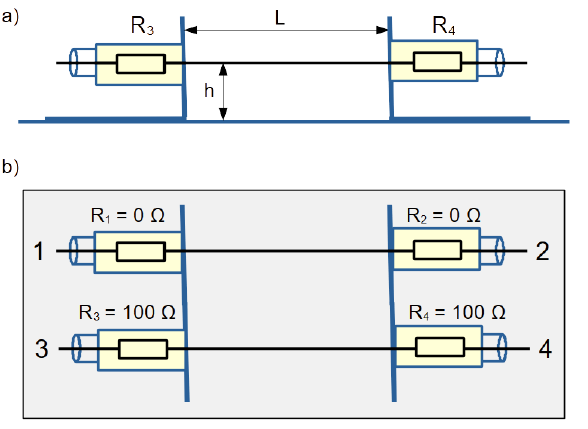
Figure 4. A simple four-port composed of two paths: side view ( a ) and bird’s eye view ( b ). The four-port was built with two single paths. Each path possessed two adapters, each composed of an N-connector to a laboratory cable 4 mm socket, mounted in the L-shape aluminum profile, which were placed face to face at the height of h = 3 cm above the reference plate and connected with a copper cylindrical rod with a diameter of φ = 2 mm and a length of L = 14